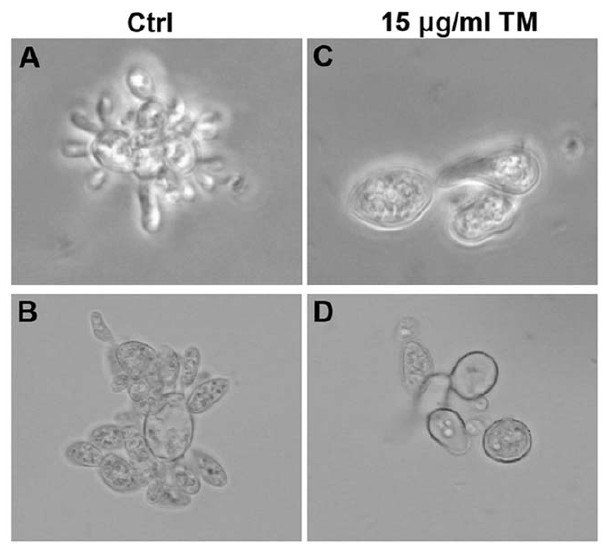
Figure 2. Effect of tunicamycin (TM) on the morphology of P. brasiliensis yeast cells. P. brasiliensis was grown in YPD medium in the absence (Ctrl), or in the presence of 15 m g/mL TM for 72 h at 37 u C and analyzed by optical microscopy (A and C) and phase-contrast microscopy (B and D).